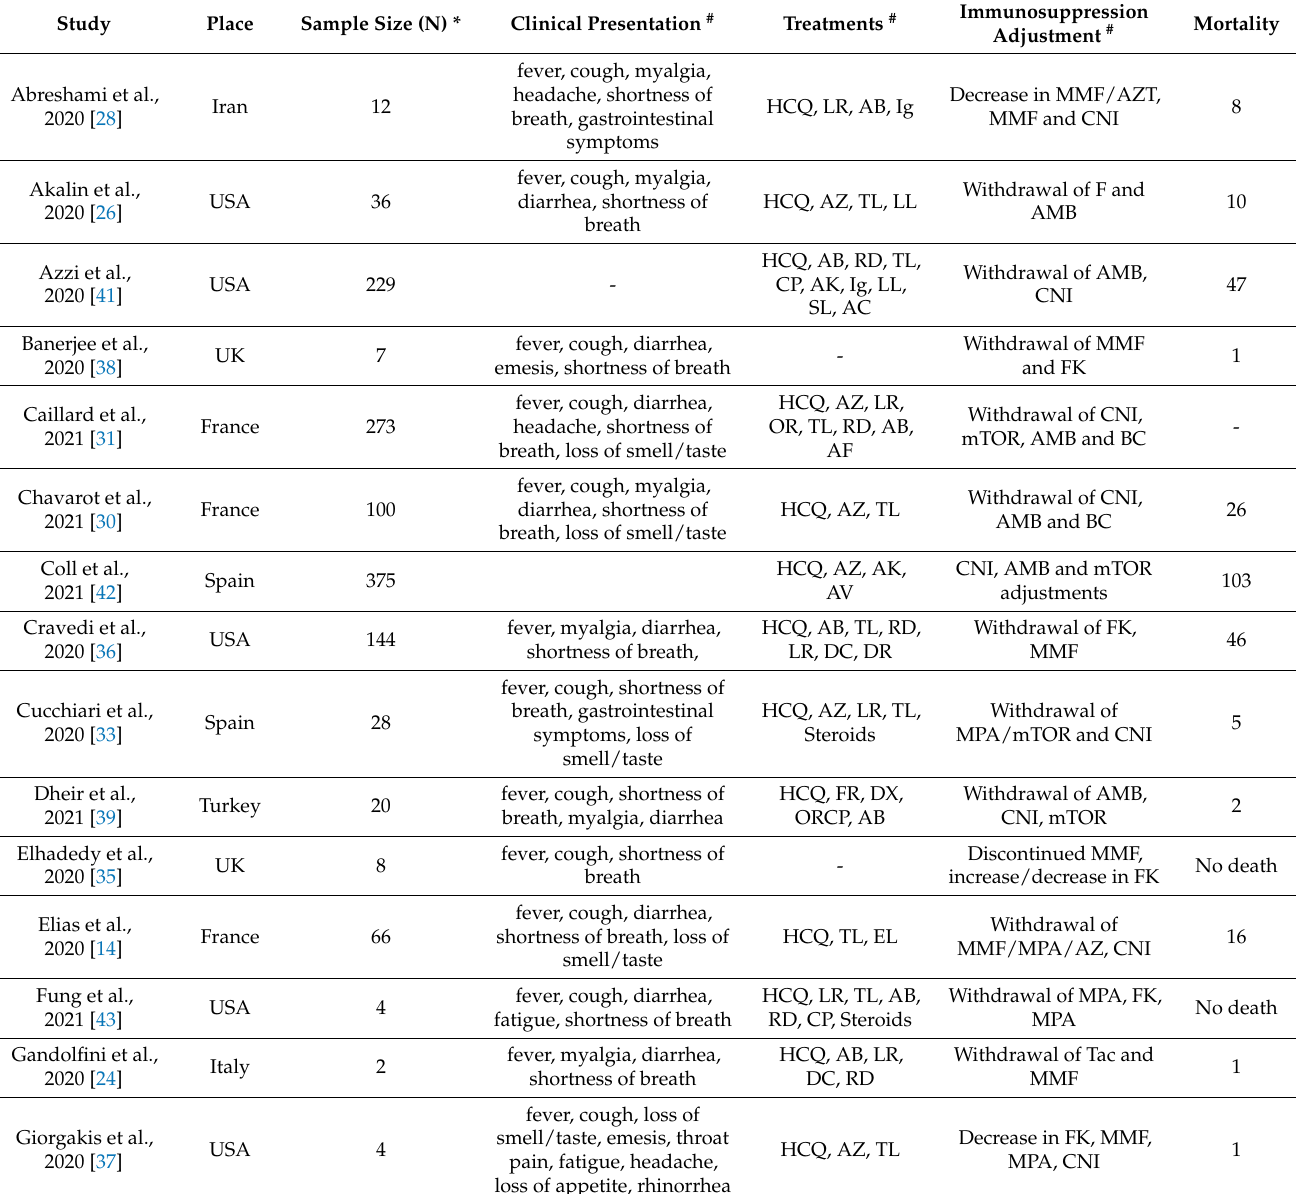
Table 1. Clinical presentation, treatments and outcomes of COVID-19 in KTx